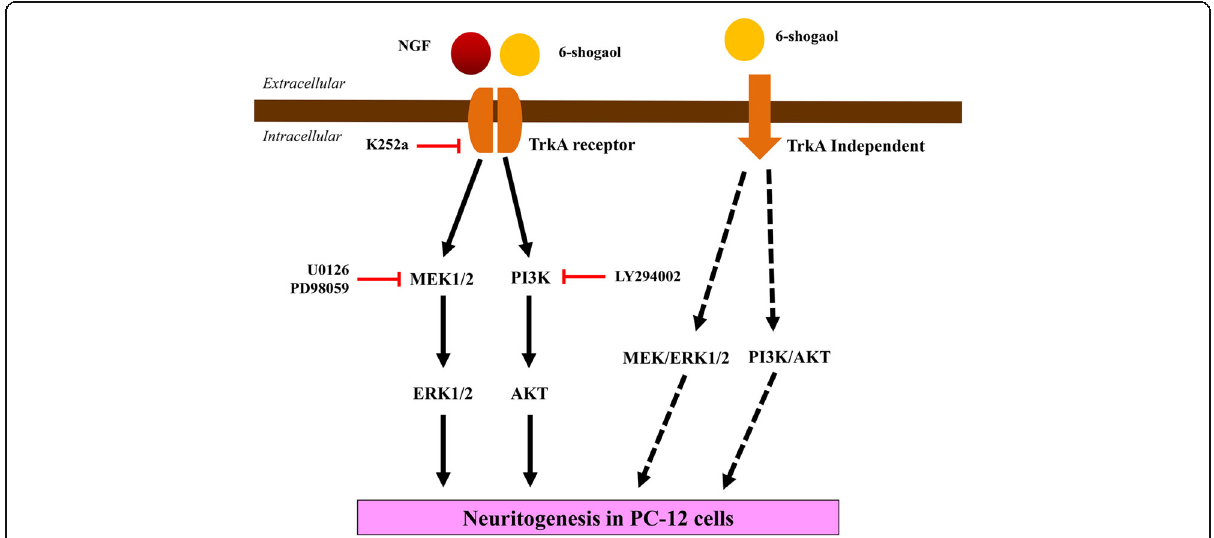
Fig. 7 Hypothetical mechanisms of NGF and 6-shogaol neuritogenesis in PC-12 cells . Nerve growth factor induced neuritogenesis via binding to its high affinity TrkA receptor and leads to the activation of two major signaling pathways, the MEK/ERK1/2 and PI3K/AKT. Addition of Trk inhibitor (K252a), MEK/ERK1/2 inhibitors (U0126, PD98059) and PI3K/AKT inhibitor (LY294002) inhibited NGF-induced neuritogenesis in PC-12 cells. In the present study, the neuritogenic activity of 6-shogaol was inhibited by U0126, PD98059 and LY294002, but only partially inhibited by K252a. Therefore, based on the present findings, both the TrkA-dependent and TrkA-independent initiated MEK/ERK1/2 and PI3K/AKT signaling pathways were involved in 6-shogaol-induced neuritogenesis in PC-12